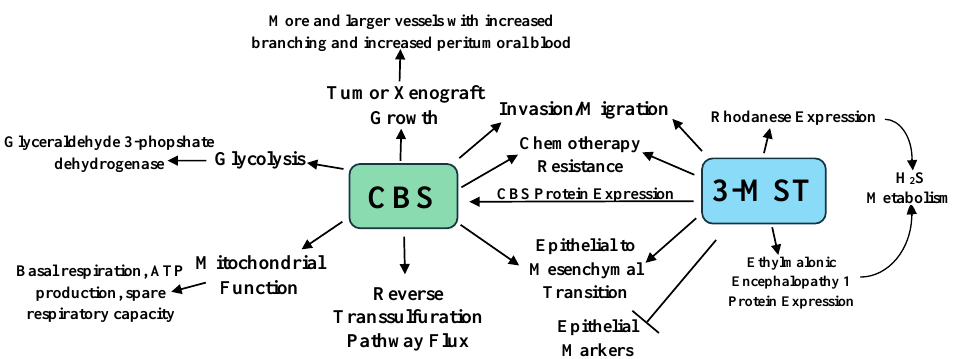
Figure 1. A summary of the roles of CBS, 3-MST, and H2S in colon cancer growth, progression, metastasis, and chemotherapy resistance [41 – 49].